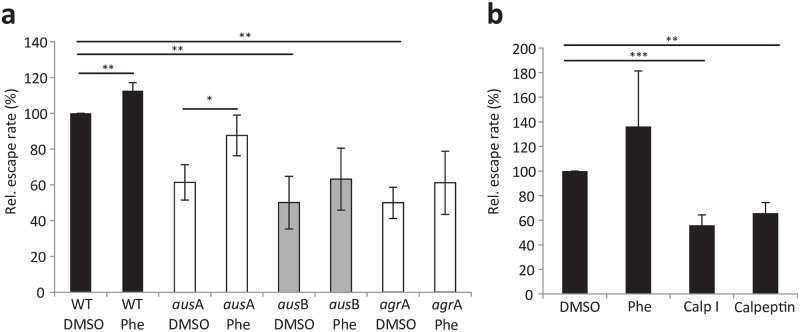
Synthetic phevalin increases phagosomal escape rates of S. aureus.
a) At the time of infection, 10 μM phevalin was added simultaneous with S. aureus JE2 wild type (WT) or mutant strains to host cells. Concentration-dependent increase in phagosomal escape rates of bacteria was observed in the phevalin-treated samples when compared to solvent control. b) Phevalin does not act as calpain inhibitor. During infection with S. aureus (WT), host cells were either treated with 10 μM phevalin (Phe), calpain inhibitor I (Calp I), Calpeptin, or solvent control (DMSO). Whereas Calp I and Calpeptin caused a significant reduction of S. aureus phagosomal escape, phevalin did not, thereby suggesting a different mode of action of the pyrazinone. Bar graphs show the mean of three independent experiments ± SD. Statistical analysis was performed by t-test. *P<0.05; **P<0.01; ***P<0.001.